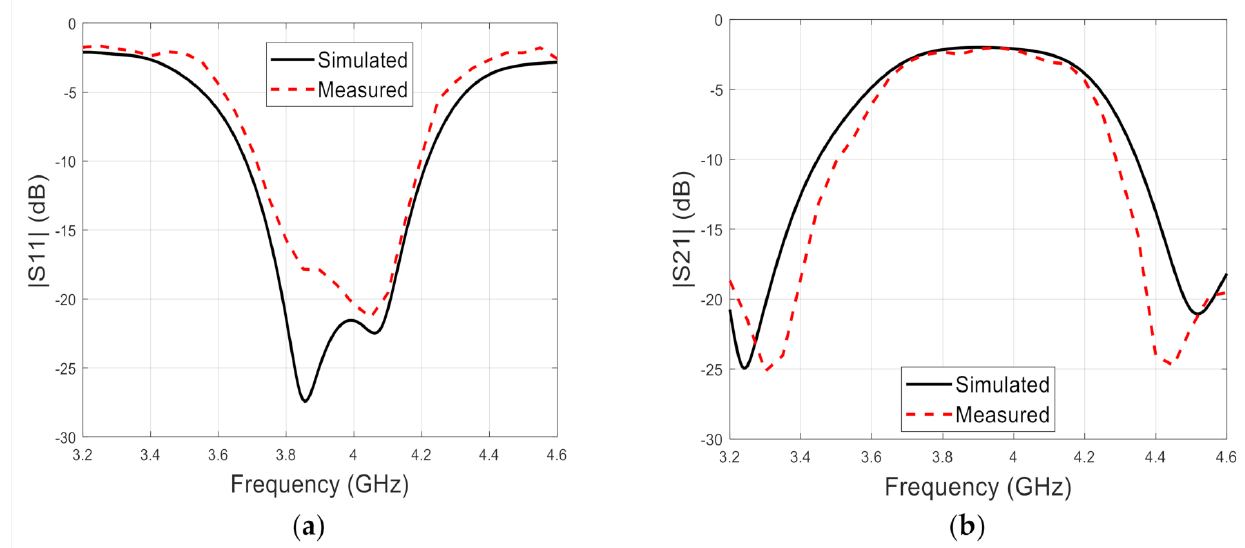
Figure 11. Measured versus simulation scattering parameters of the proposed microwave filter: ( a ) reflection coefficient; and ( b ) transmission